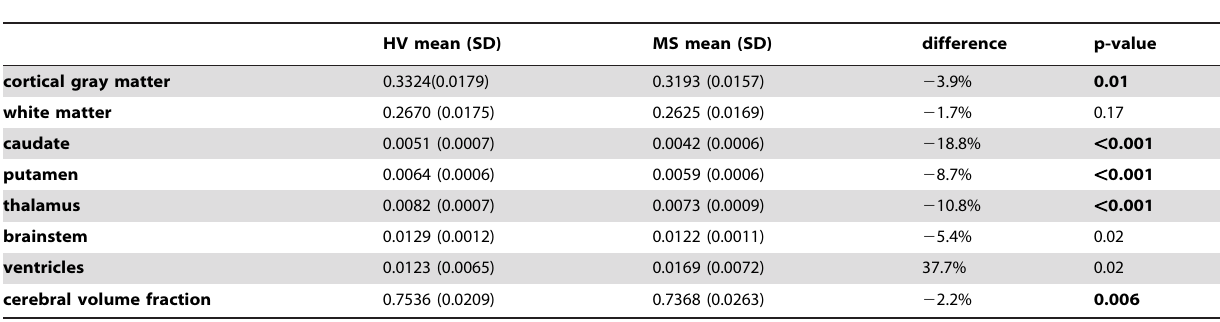
Table 3. Normalized brain structure